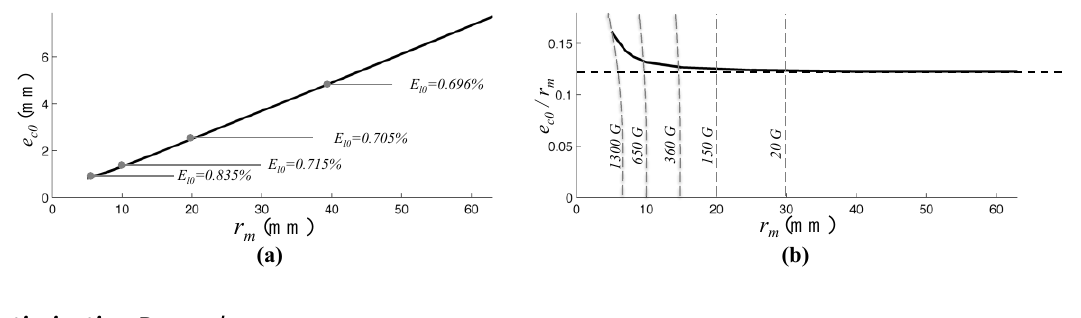
Figure 5. ( a ) Estimated optimum eccentricity in function of the radius of measurement in a range ; ( b ) Estimated ratio between the optimum eccentricity and the radius of measurement. Both plots refer to cylindrical magnet with